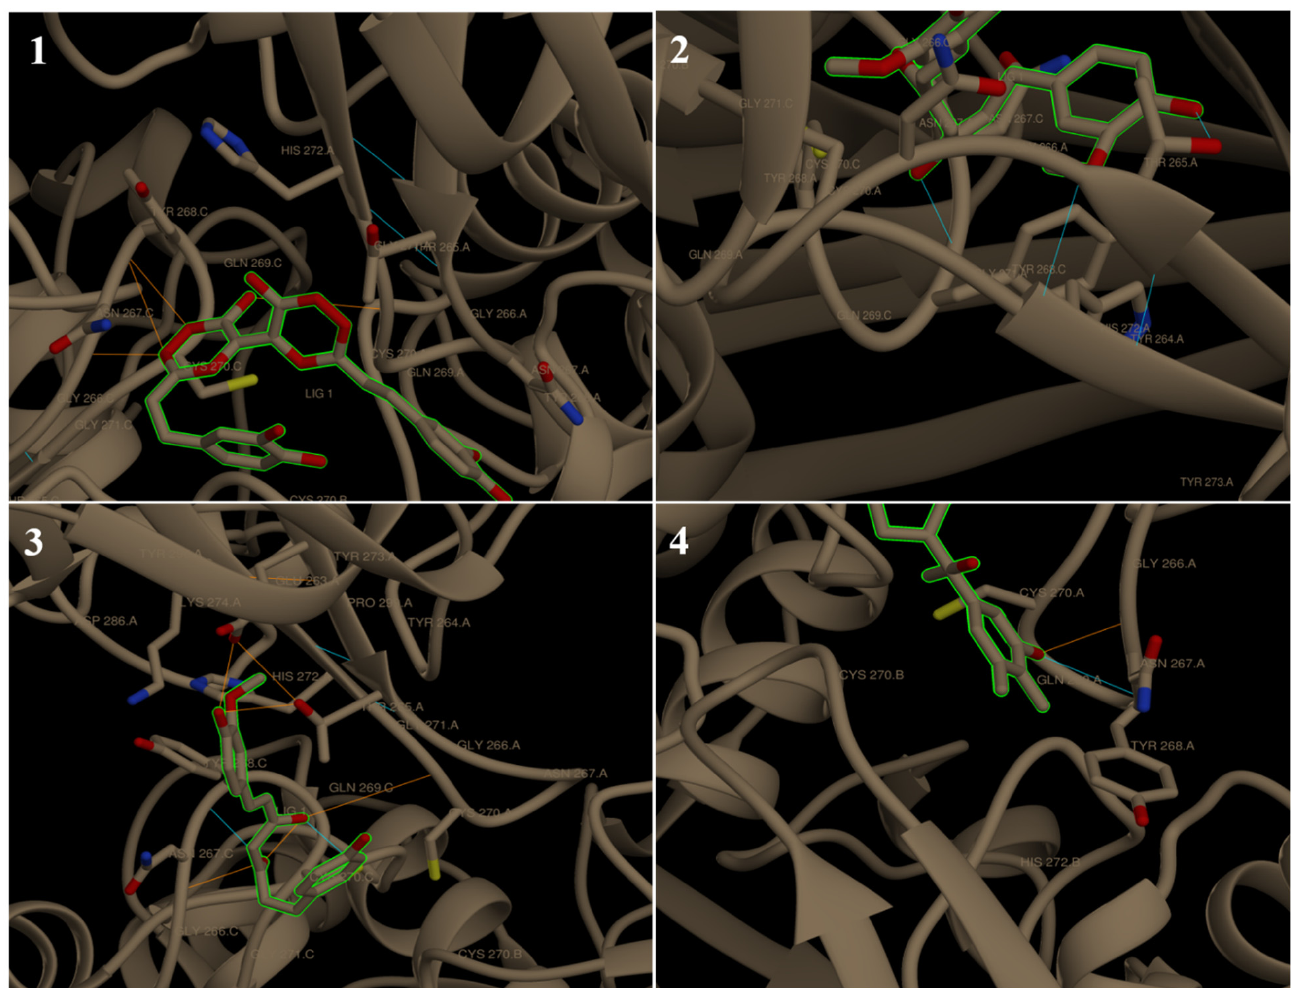
Figure 2. Histogram showing molecular docking results between ( A ) 6W9C, ( B ) 6M17, and ( C ) 6M71 and several drug candidates compounds (the binding energy value Δ G is shown in minus kcal/mol).